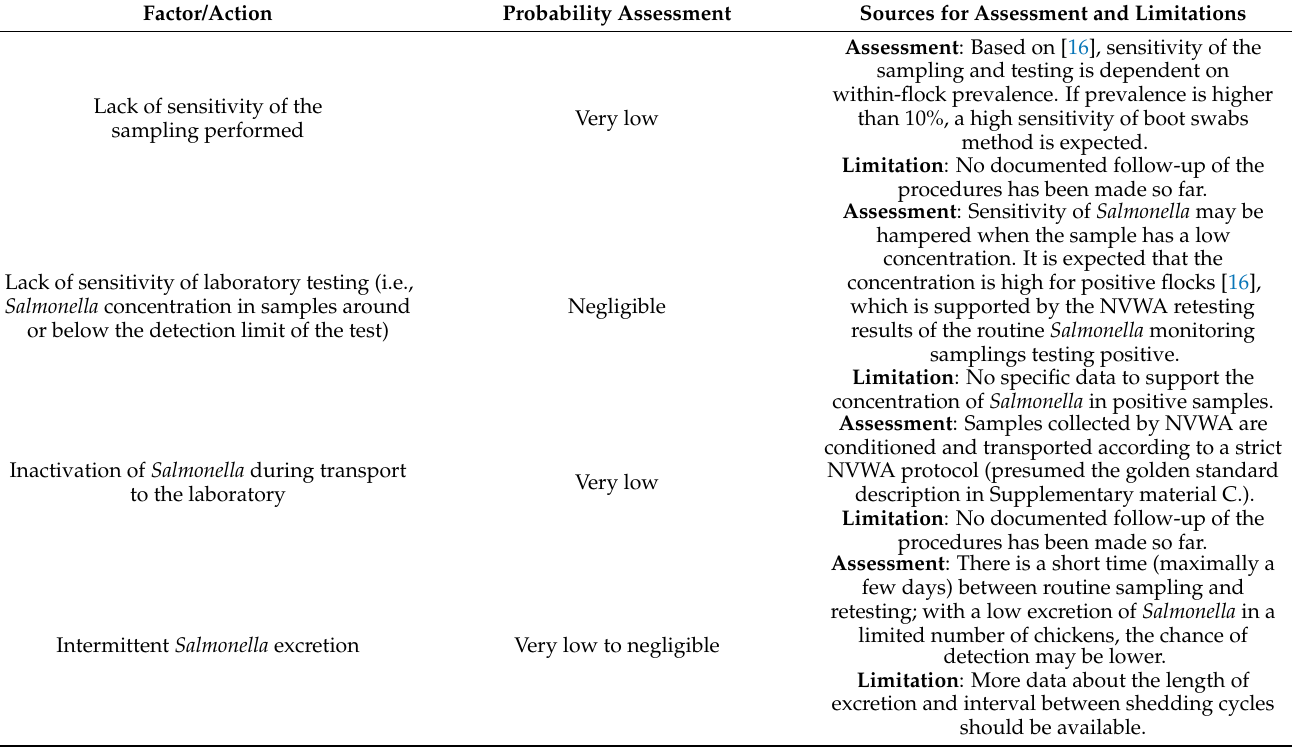
Table 5. Summary of assessed factor/actions which could be associated with an incorrect retest negative test result.